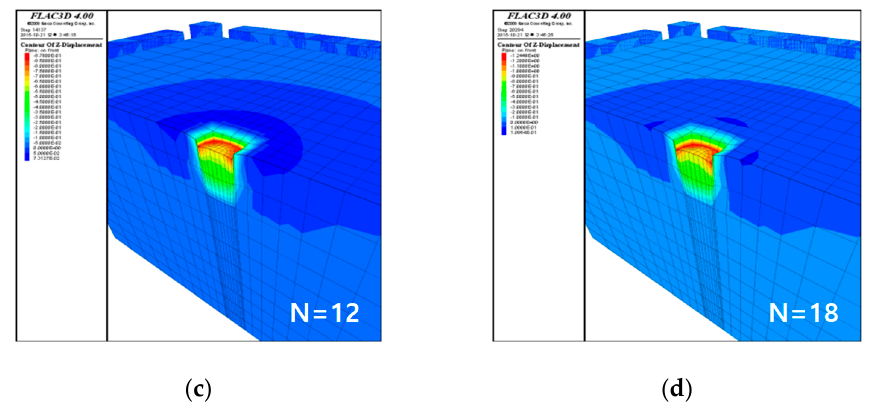
Figure 13. Vertical displacement with increase in number of drops (D = 4 m, W = 20 tons, H = 15 m): ( a ) settlement increase with N; ( b ) vertical displacement contour (N = 5); ( c ) vertical displacement contour (N = 12); ( d ) vertical displacement contour (N = 18).